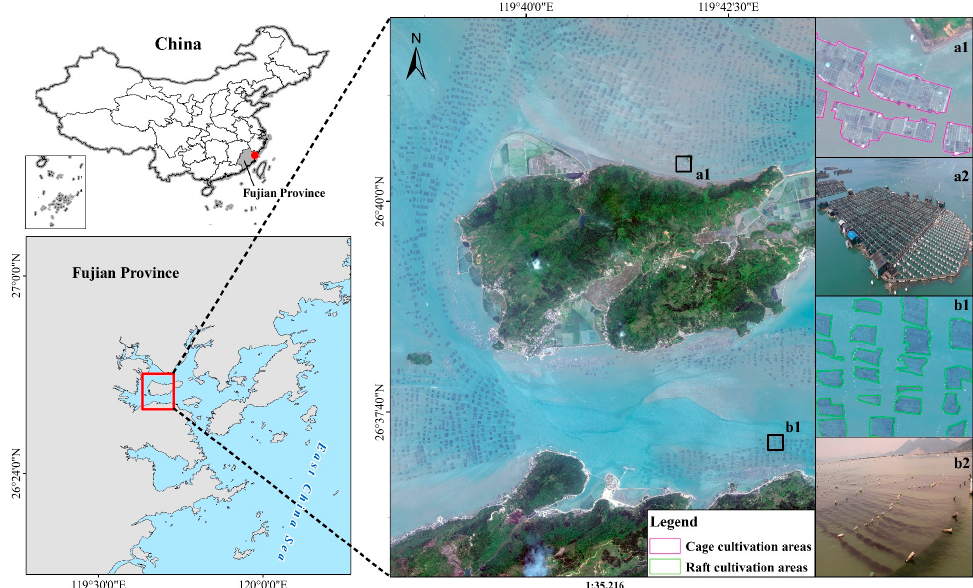
Figure 1. The study area Sandu Island is a typical marine aquaculture area in Ningde City, Fujian Province, China. The image here shows a Worldview-2 image of the study area in true color with image examples for cage culture areas (CCA) and raft culture areas (RCA) on the satellite ( a 1 and b 1, respectively) and ground ( a 2 and b 2, respectively) and ground ( a 2 and b 2, respectively).